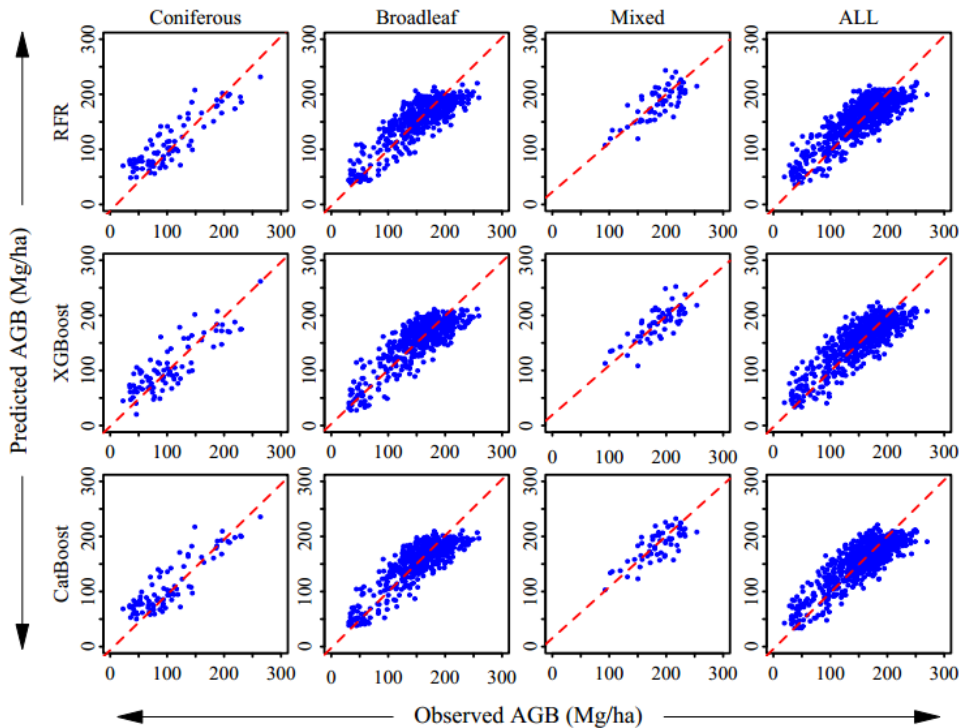
Figure 5. Scatter plot of the predicted and observed AGB of the RFR, XGBoost, and CatBoost algorithms for different forest types. The dashed line shows an optimal model fit.